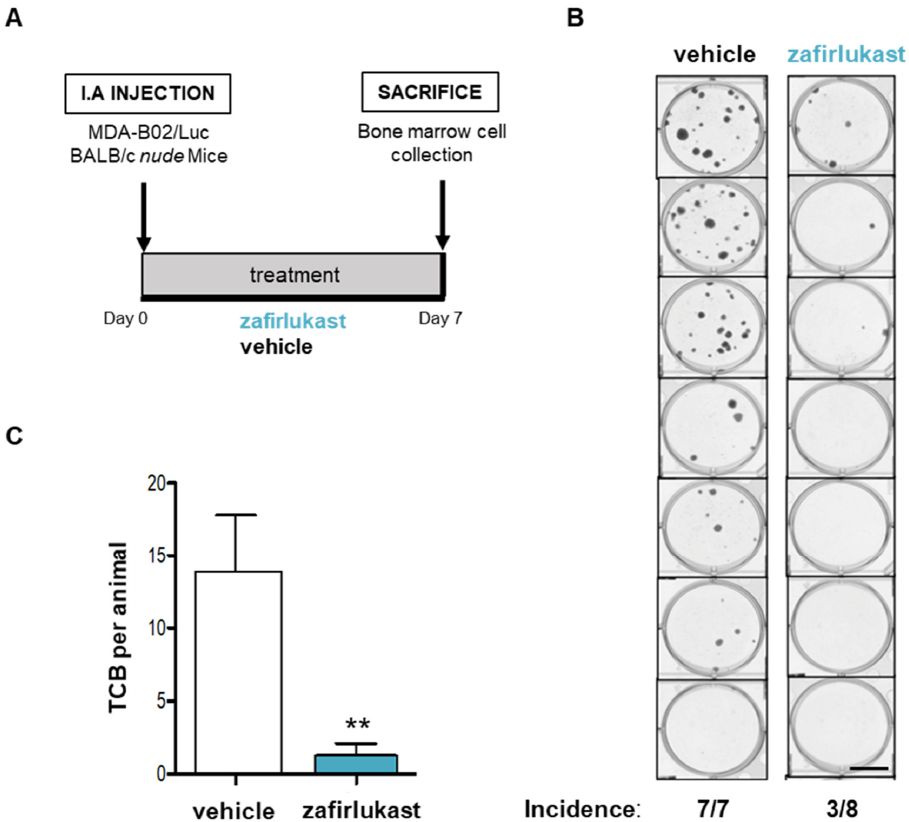
Figure 6. Blockade of CysLT1R with zafirlukast prevents early bone colonization of human breast cancer cells in BALB/c nude mice. ( A ) MDA-B02-Luc cells were injected into the tail artery (IA) of BALB/c nude mice that received a daily treatment with zafirlukast (0.4 mg/kg per os) or the vehicle (physiological serum). After 7 days, bone marrow cells were collected and placed in culture in presence of puromycin (1 µg/mL) for 14 days. ( B ) Tumor cells that colonized the bone (TCB) were fixed and stained by crystal violet (scale: 100 µm). ( C ) TCB were quantified. The data represent the mean number of TCB ± SD (vehicle: 7 mice; zafirlukast: 8 mice). ** p < 0.005 vs. vehicle; Mann–Whitney test). Abbreviations: IA = intra-arterial.